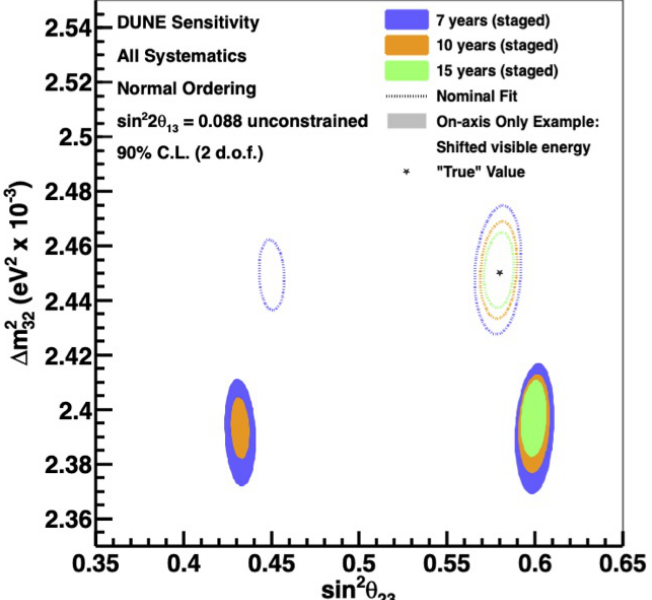
Figure 99. Results of a fit to both the nominal MC (dashed) and the mock data samples (solid). The true values of ∆ m 2 and sin 2 θ 23 are given by the star, and the allowed 90% C.L. regions are drawn 32 around the best-fit point, for 7, 10, and 15 years of